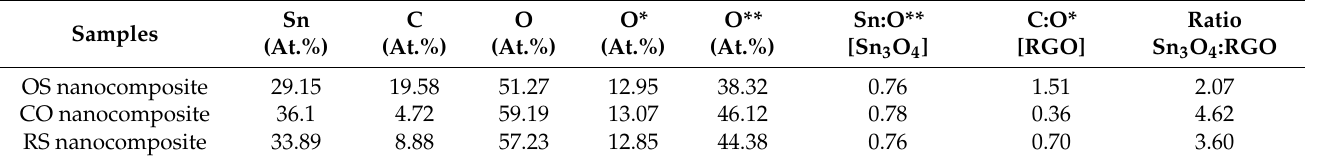
Table 1. The fitting results of the content and content ratio of each atom for OS, CO, and RS nanocomposites.